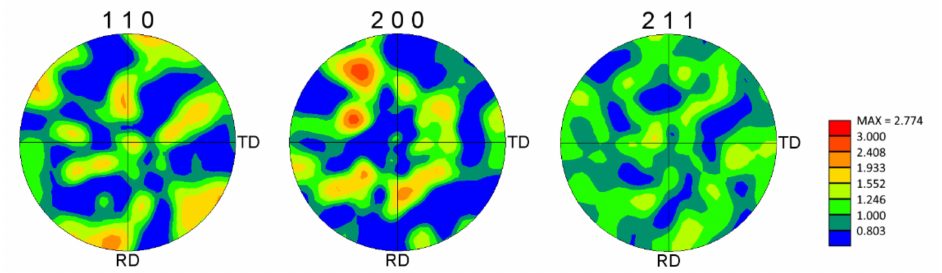
Figure 9. 110, 200 and 211 pole figures calculated from the EBSD mapping of the WCr4 sample presented in Figure 7.